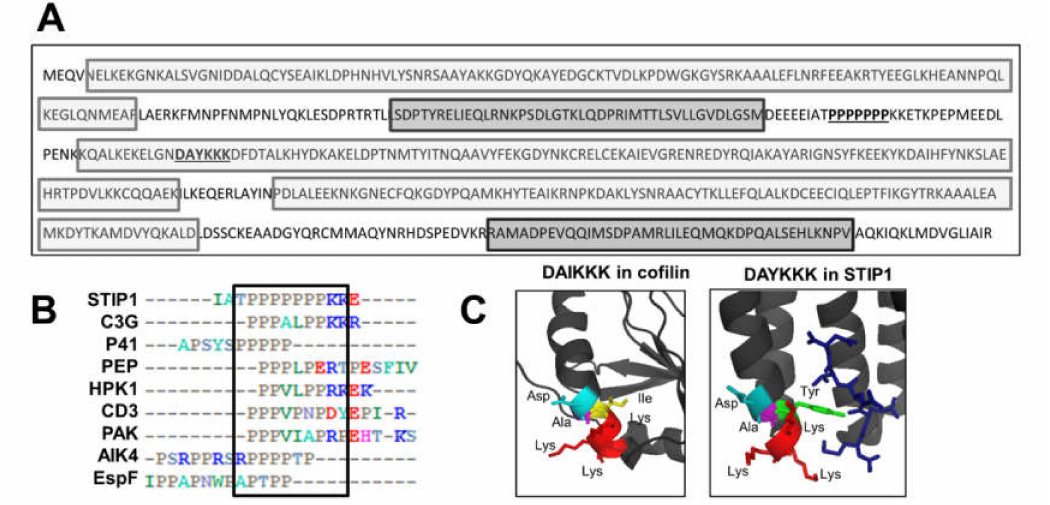
Figure 3. Identification of putative actin-binding sites in STIP1 sequence. ( A ) Amino acid sequence of STIP1. The light and dark shaded boxes show the three TPR domains and the two DP domain sequences, respectively. The underlined residues indicate the polyproline and DAYKKK motif. ( B ) Alignment of the putative SH3-binding motif of STIP1 with other known peptides or proteins that bind SH3 domain, using Clustal Omega software and edited by BioEdit programme. The negatively charged, positively charged and neutral amino acids are shown in red, blue and grey, respectively. The other colours indicate amino acids of similar properties. The conserved polyproline region with basic amino acids is shown with black outline. ( C ) Structure of human cofilin ( left , PDB:1Q8X) and the TPR2A domain of STIP1 ( right , PDB:1ELR). Coloured residues represent the canonical and putative actin-binding motifs DAIKKK and DAYKKK, respectively. The residues are indicated as follows: aspartic acid (cyan), lysine (red), alanine (magenta), isoleucine (yellow) and tyrosine (green). Structures were rendered in